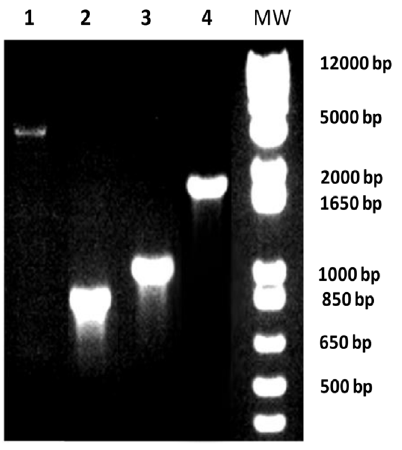
Figure 2. Analysis of the lpxL1andsynX gene PCR products from wild type and vaccine strains. lpxL1 and synX gene PCR products obtained from the amplification of wild type and mutant ( D lpxL1 D synX ) NZ9547 N. meningitidis strain genomic DNA. The lpxL1 gene PCR products obtained from the amplification of mutant and wild type genomic DNAs are shown in lanes 1 and 2 respectively. The synX gene PCR products obtained from the amplification of wild type and mutant genomic DNA are shown in lanes 3 and 4 respectively.